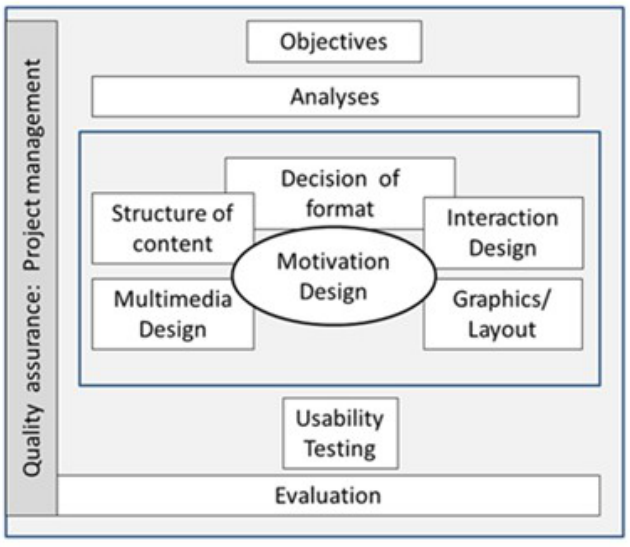
Figure 4. DO-ID model (in orientation to Niegemann, et al., 2008, p.